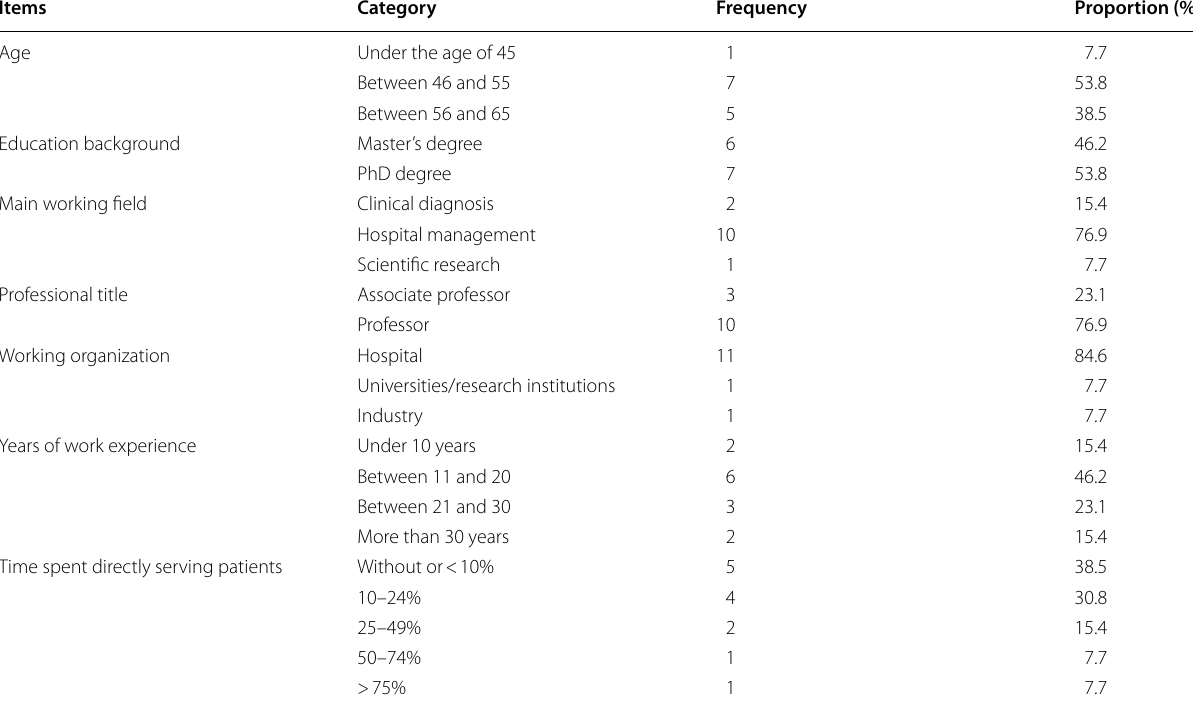
Table 1 Basic information on